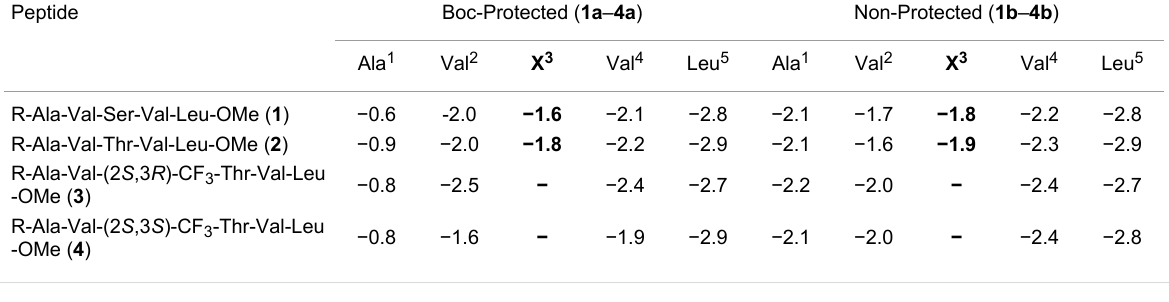
Table 2: 13 C α chemical shift deviations (CSD) of residues in pentapeptides 1a – 4a and 1b – 4b in CD 3 OH (298 K). Peptide Boc-Protected ( 1a – 4a )